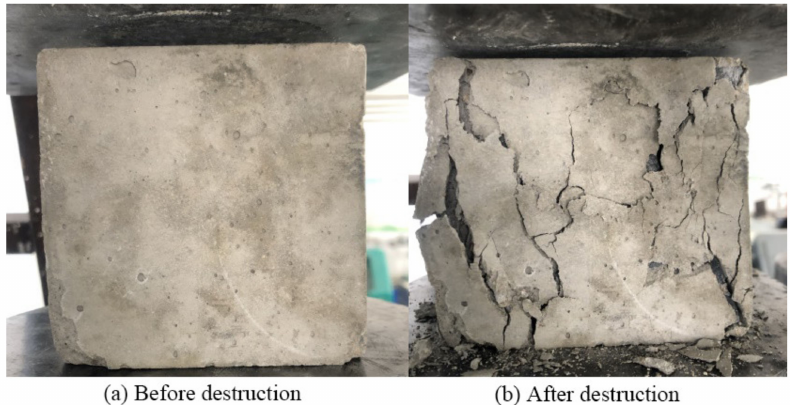
Figure 1. Unconfined compression test of cube. Table 4. Experimental scheme of concrete columns with different composite material constraints. Fiber Sheet Concrete Column Paste Layers Number of Samples Wrapping Sequence CC